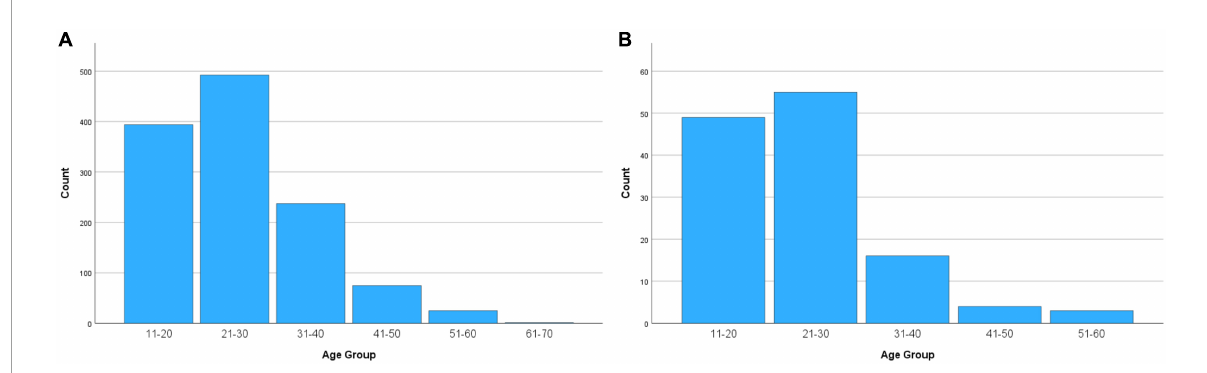
FIGURE1 Distribution of (A) persistent restless legs syndrome (RLS) and (B) RLS causing significant daytime impairment according to